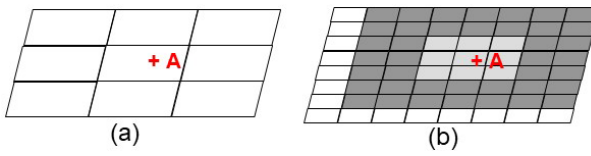
Figure 4. Scale diagram of the same region in (a) a 2.5km grid-cell size simulation and (b) a 1km grid-cell size simulation. Region en- closed by light grey (dark grey) shading in (b) represents the nearest 9 (49) 1km grid points surrounding the observation location